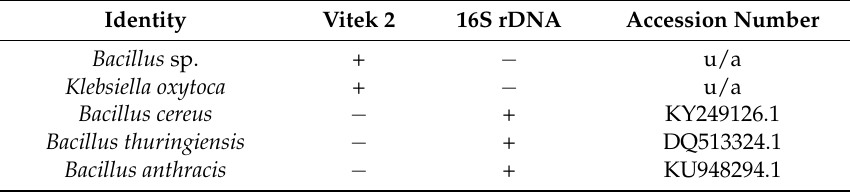
Table 4. Identity of bacteria isolated from N. mirabilis digestive